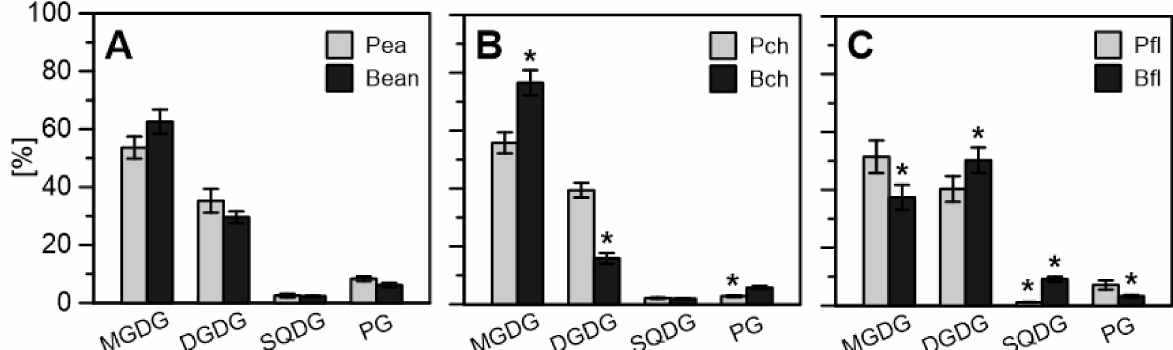
Figure 7. Composition of polar glycerolipids (MGDG, DGDG, SQDG, and PG) in pea and bean plastoglobules (PGs): ( A ) control conditions; ( B ) after the 7th day of chilling stress treatment (ch) and ( C ) in the first leaf (fl). Results marked with an asterisk (*) differ significantly at p = 0.05 comparing to control conditions (one-way ANOVA with posthoc Tukey